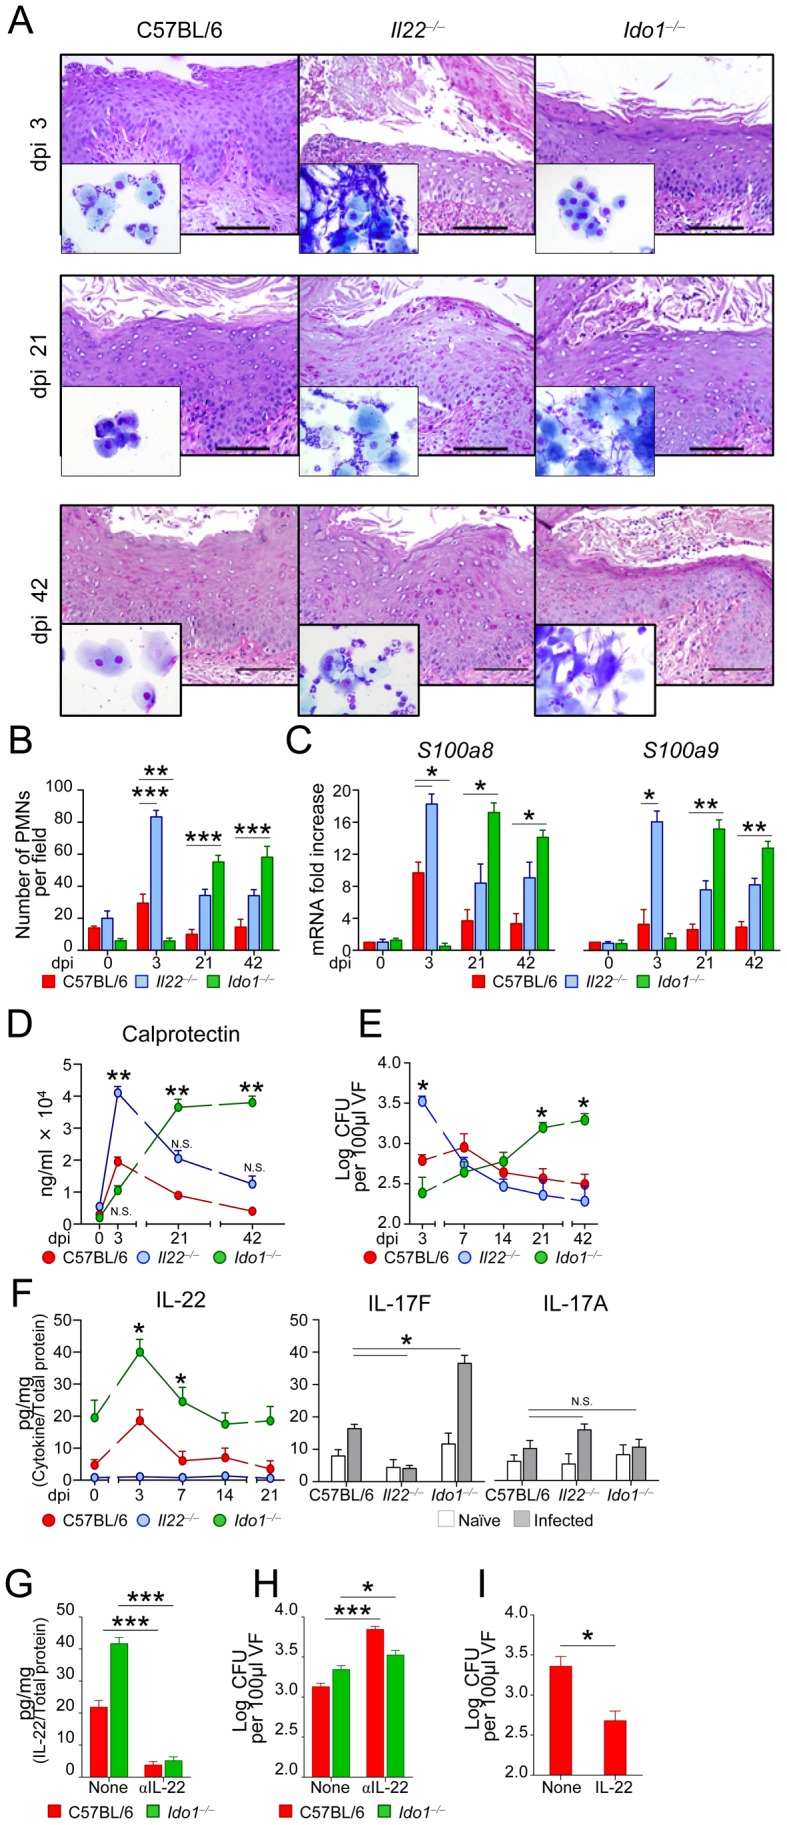
Vaginal candidiasis in IL-22- or IDO1-deficient mice.C57BL/6, IL-22- or IDO1-deficient mice (n = 6) were intravaginally inoculated with 5×106
C. albicans blastoconidia. (A) Periodic acid-Schiff-staining of vaginal sections and inflammatory cell recruitment in vaginal fluids (May–Grünwald Giemsa staining in the insets) at different days post-infection (dpi). Representative images of histology sections and vaginal fluids were acquired with a 40× and 100× objective respectively. Scale bars, 100 µm. (B) Polymorphonuclear cells (PMNs) quantification in the vaginal fluids. PMNs were identified by nuclear morphology and enumerated per field at ×100 magnification. Each point represents an individual mouse, and horizontal bar indicates the means. **P<0.01 and ***P<0.001, IDO1- or IL-22-deficient vs. wild-type mice at the indicated days. (C) S100a8 and S100a9 mRNA expression in vaginal tissue by real-time RT-PCR. The mRNA-normalized data were expressed as relative mRNA in IDO1- or IL-22-deficient vs. wild-type mice. *P<0.05 and **P<0.01, IDO1- or IL-22-deficient vs. wild-type mice at the indicated days. (D) Levels of calprotectin during vaginal candidiasis. **P<0.01, IDO1- or IL-22-deficient vs. wild-type mice. (E) Vaginal fungal burden in mice at different dpi. CFU were quantified by culturing serial dilutions of vaginal fluids (VF) from each mouse and expressed as Log10 CFU/100 µl VF ± s.e.m. *P<0.05, IDO1- or IL-22-deficient vs. wild-type mice at the days indicated. Data are pooled or representative (histology) from four independent experiments. (F) Cytokine levels (pg/mg, cytokine/total proteins for each sample) in the vaginal fluids (at 3 dpi for IL-17F and IL-17A). Results represent mean cytokine levels (± s.e.m.) from samples pooled from three experiments (n = 4–6 total samples per group). *P<0.05, IDO1- or IL-22-deficient vs. wild-type mice. (G) Levels of IL-22 (pg/mg, cytokine/total proteins) and (H) fungal growth (at 3 dpi) in mice treated with 300 µg of mAb neutralizing IL-22 or isotype control mAb (None) given intraperitoneally the day of and 1 day after the primary infection. (I) Fungal growth (at 3 dpi) in mice treated intravaginally with rIL-22 or PBS (None) the day of and 1 and 2 days after the infection. Pooled data from two experiments (n = 6). *P<0.05 and ***P<0.001, treated vs. untreated mice. N.S., not significant.